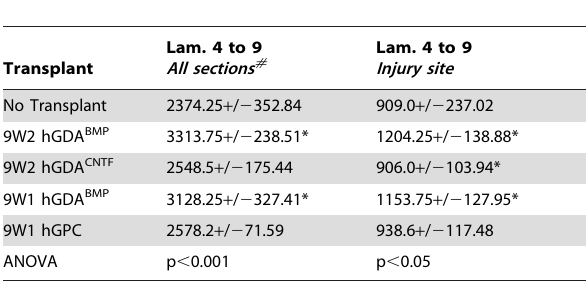
Table 1. Survival of NeuN + neurons 5 weeks post